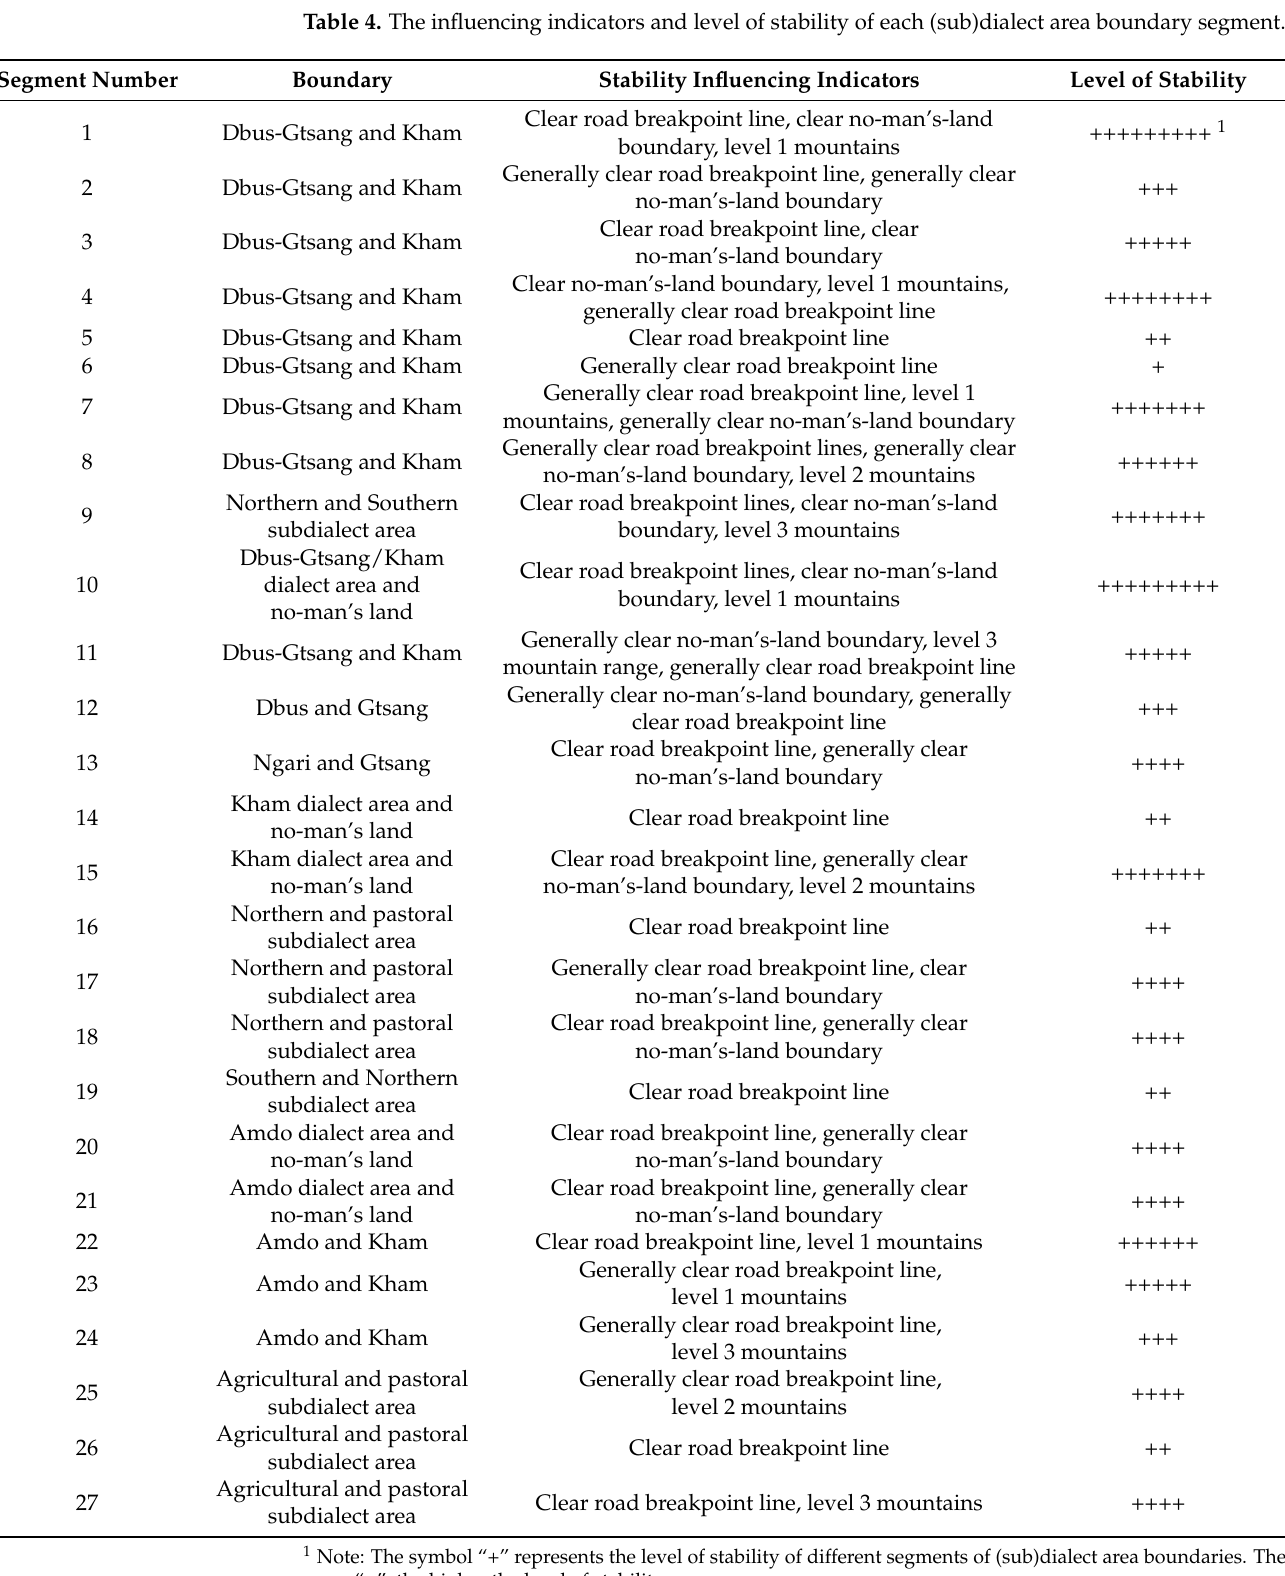
Table 4. The influencing indicators and level of stability of each (sub)dialect area boundary